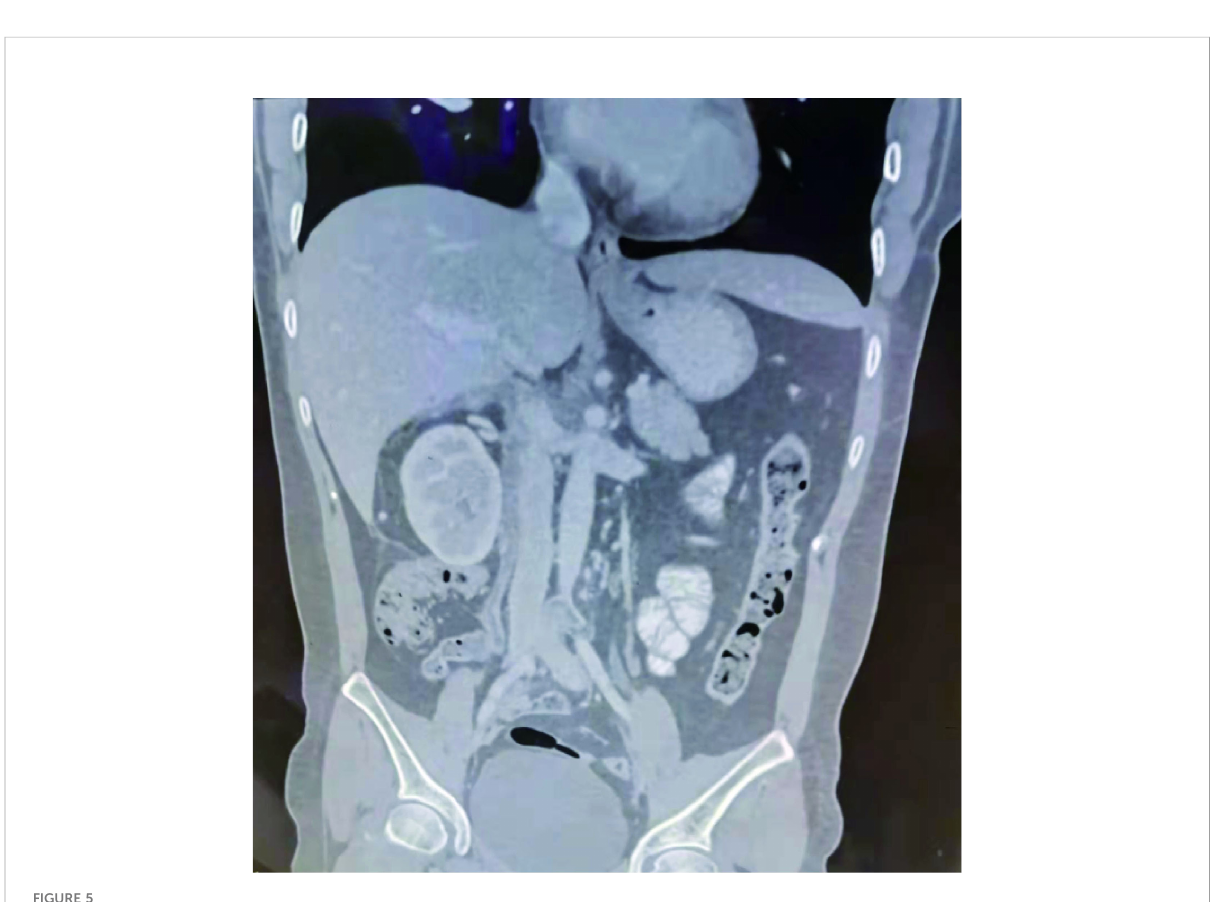
FIGURE 5 Abdominal CTA 3 months after